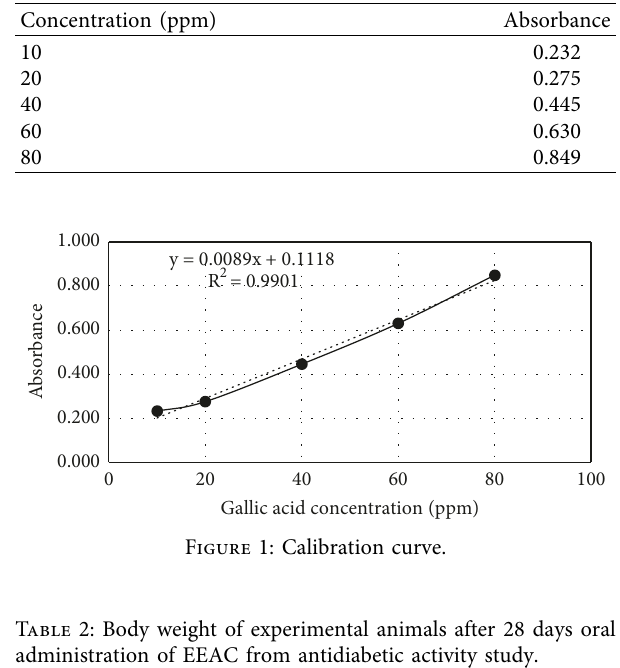
Table 1: Gallic acid absorbance.